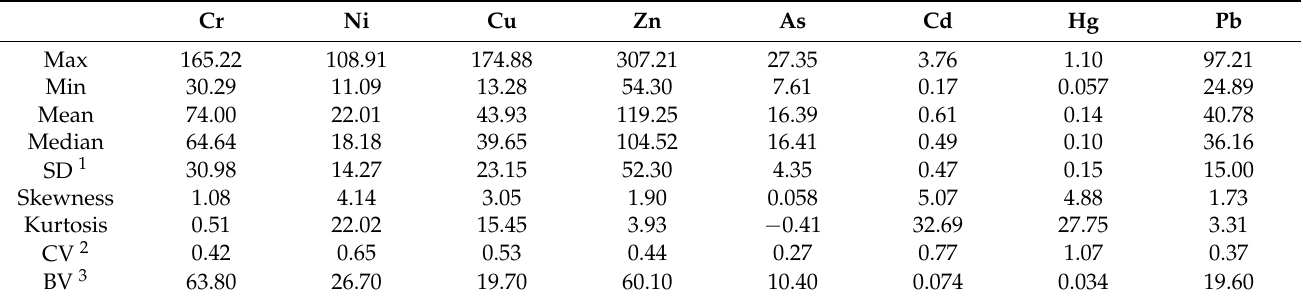
Table 1. PTE concentrations (mg/kg) in road dust collected from